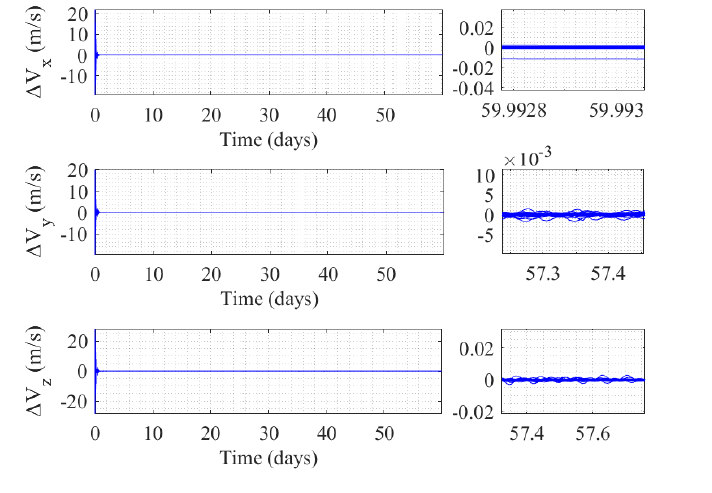
Figure 22. Control effects of constellation